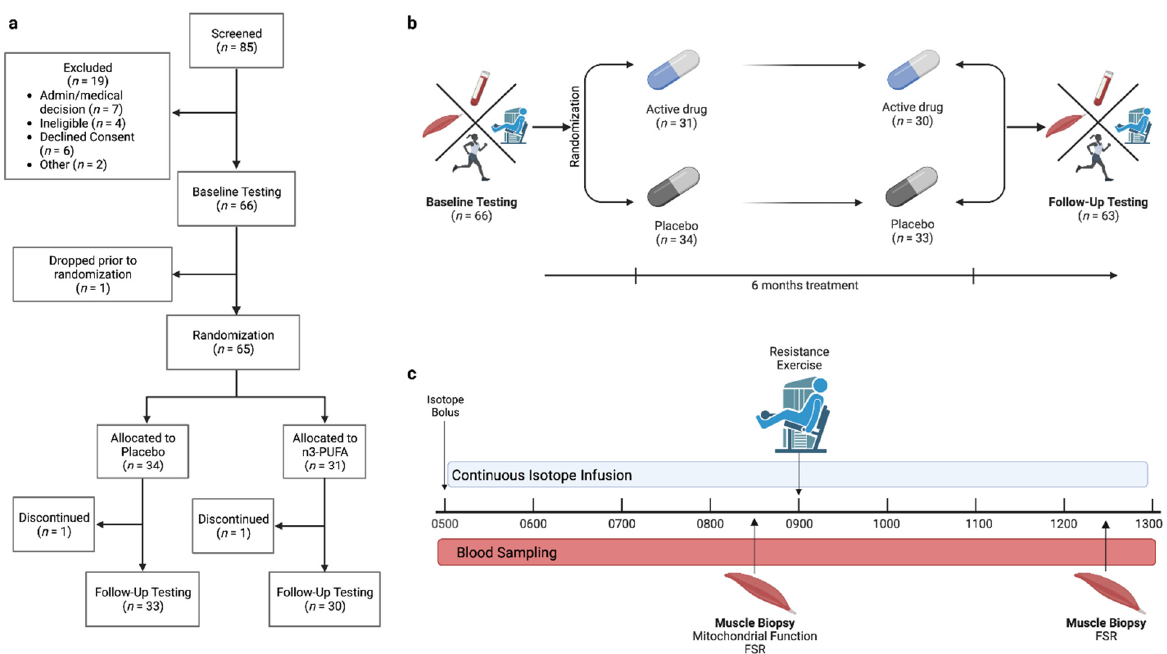
Figure 1. Participant enrollment and study design. ( a ) Enrollment numbers and flow chart for the study. ( b ) Overall study design of the intervention, which included baseline and follow-up assess- ments of physical activity, cardiorespiratory fitness, muscle strength and function, mitochondrial physiology, body composition, and whole-body and mixed muscle protein synthesis. All assessments were completed before and after 6 months of placebo or n3-PUFA supplementation, administered in a randomized, double-blind design. ( c ) Study design for the inpatient study day. Figure created using